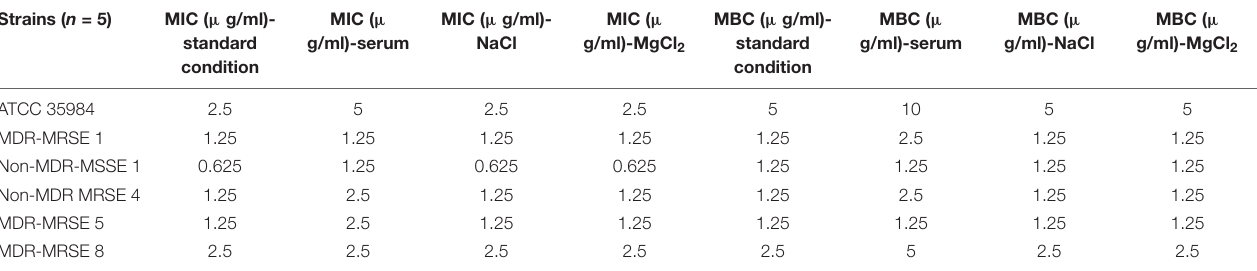
TABLE 7 | Minimum inhibitory concentrations, and minimum bactericidal concentrations of melittin after encounter to serum and salts against selected Staphylococcus epidermidis strains. Strains ( n = 5) MIC ( µ g/ml)-